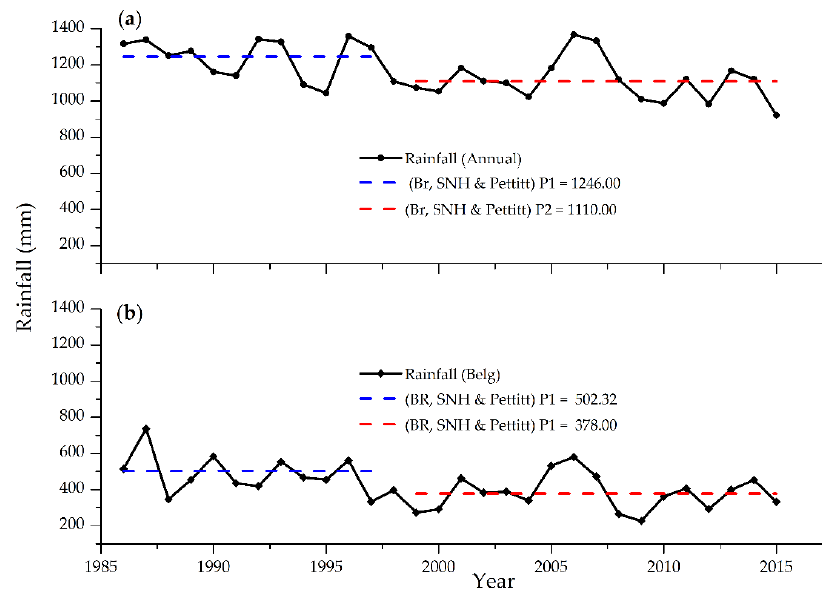
Figure 8. Changing point detection of rainfall in the Bilate watershed for the period 1986–2015: ( a ) the annual and ( b ) the Belg season.